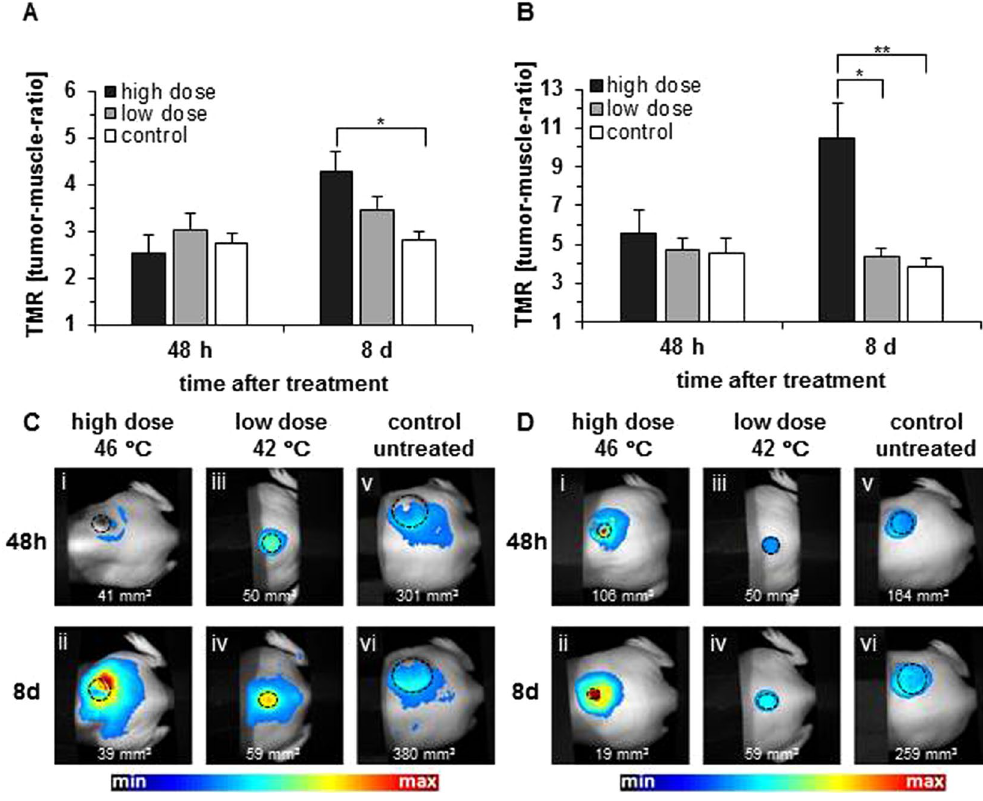
Figure 2. Signal intensities for GRPR and α v β 3 integrin increase after hyperthermia treatment in a period of 8 days. ( A ) Tumor-to-muscle ratios (TMR) of the temperature-dependent fluorescence intensities induced by the optical probe BombesinRSense ™ 680 (2 nmol). ( B ) Semi-quantitative analysis of fluorescence intensities induced by the optical probe IRDye ® 800CW RGD (1 nmol) at tumor areas (see methods). ( C ) Representative macroscopic images with color-coded fluorescence intensities of GRPR expression. ( D ) Representative macroscopic images with color-coded fluorescence intensities of α v β 3 integrin expression. Tumor volumes at the bottom of each picture; marked tumors in black. Controls were not subjected to any hyperthermia treatment. All data represent the mean ± SEM (n = 10 in control group, n = 9 in low dose, n = 10 in high dose hyperthermia; * p ≤ 0.05 ** p ≤